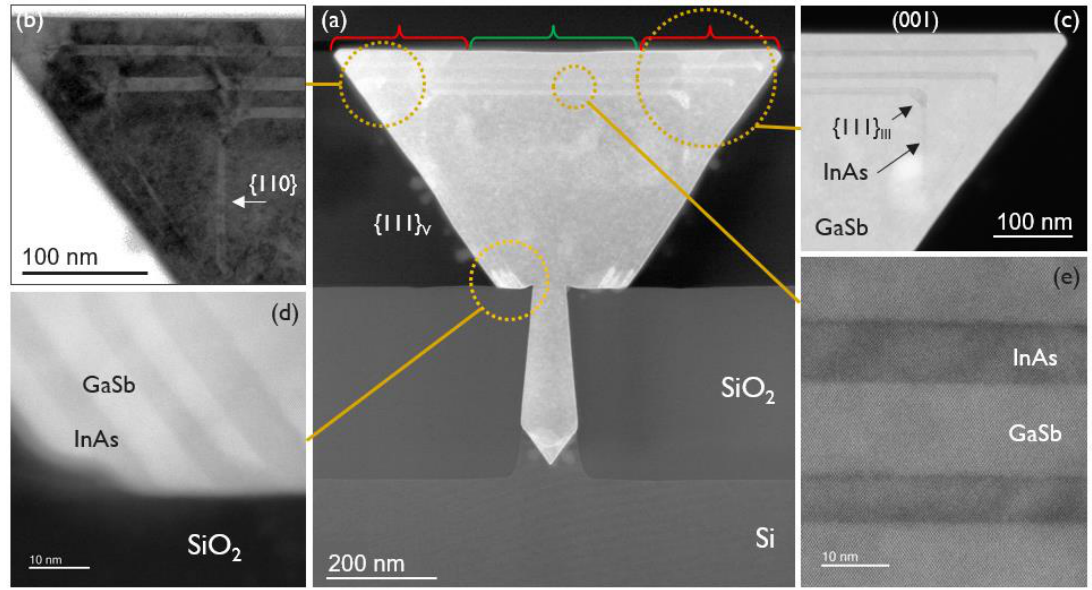
Figure 10. Summary of different TEM images prepared across the trench orientation of the multi-layer stack deposited at 500 °C. ( a ) is a DF-STEM image, ( b ) is a two-beam (004) BF and ( c – e ) are high angle annular dark field (HAADF)-STEM images with different magnification. The orange circles in (a) indicate the magnified image areas of ( b ) to ( e ) and the green and red brackets the defect-free and defective NR zones, respectively. The white spot in figure ( c ) is caused by a local Ga deposition during focus ion beam (FIB) preparation.